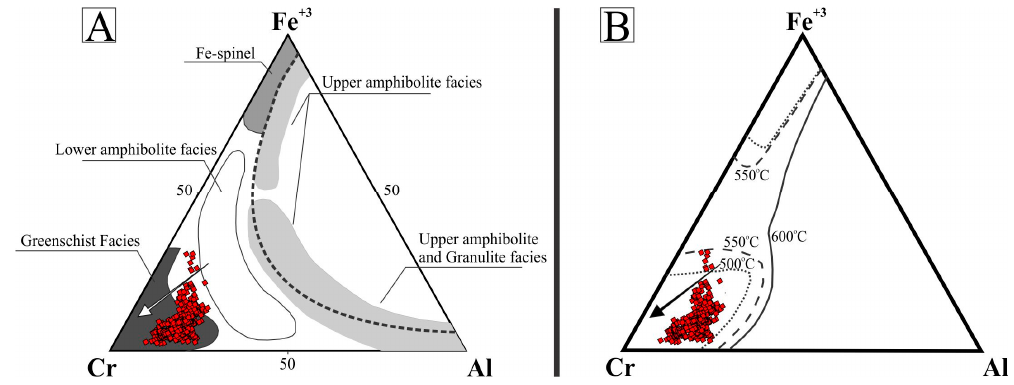
Figure 6. Ternary Cr–Al–Fe 3+ diagrams exhibiting >500 analyses of chromite from Cedrolina. ( A ) Modified after [11], with the fields of different metamorphic facies from [39–41]; ( B ) Stability limits of spinels defined for chromite and magnetite (calculated in equilibrium with Fo90 olivine). Modified after [42,43]. Both arrows (black and white) indicate the direction of metamorphic retrogression to greenschist facies.